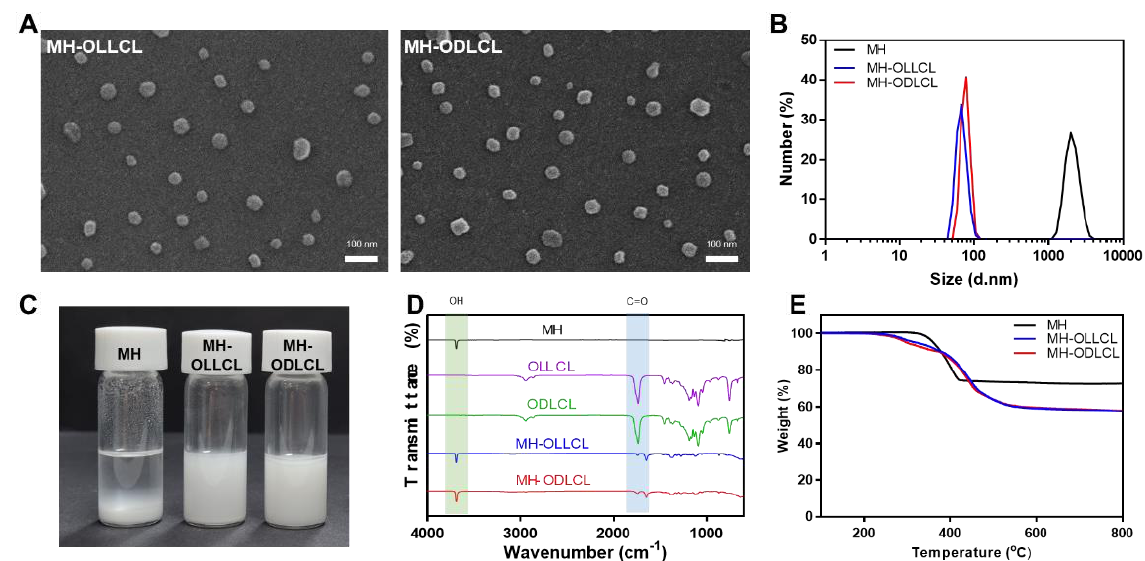
Figure 3. Characterization of the surface–modified MHs. ( A ) SEM images of the MH–OLLCL and MH–ODLCL. Scale bar: 100 nm. ( B ) Size distribution, ( C ) optical image of dispersion in an organic solvent, ( D ) ATR–FTIR spectra, and ( E ) TGA thermograms of the MHs, MH–OLLCL, and MH − ODLCL.